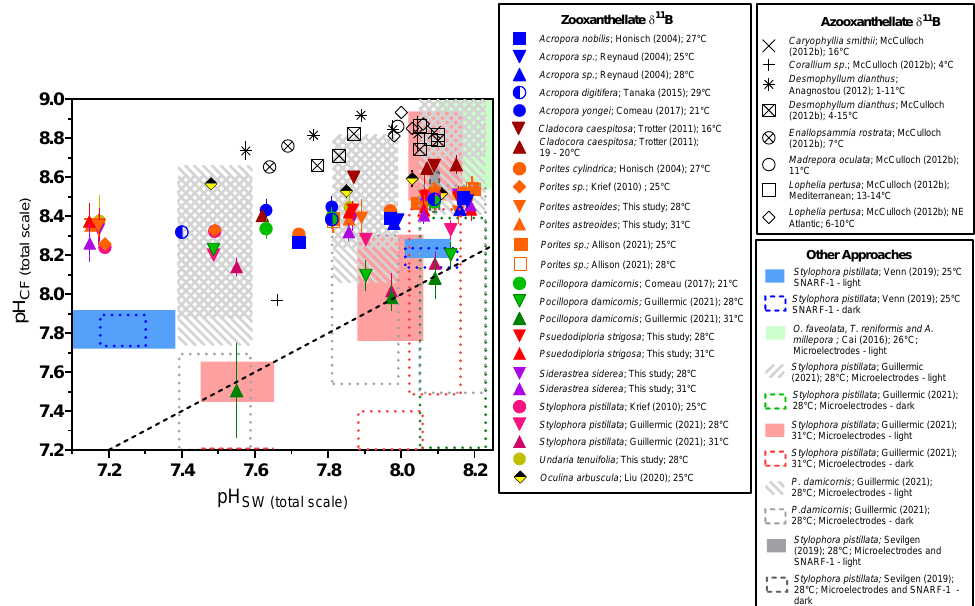
Figure 5. Compilation of δ 11 B-derived calcification fluid pH CF data from shallow-water zooxanthel- late coral culturing experiments. We include data from cold-water azooxanthellate corals as a point of reference, as well as ranges of pH CF data as determined by SNARF pH-sensitive dyes and pH microelectrode analyses. ‘RR’ label denotes corals treated with the Ca-ATPase inhibitor ruthenium red [32]. Previously published data used in the figure are available in Table S12 alongside citations for data